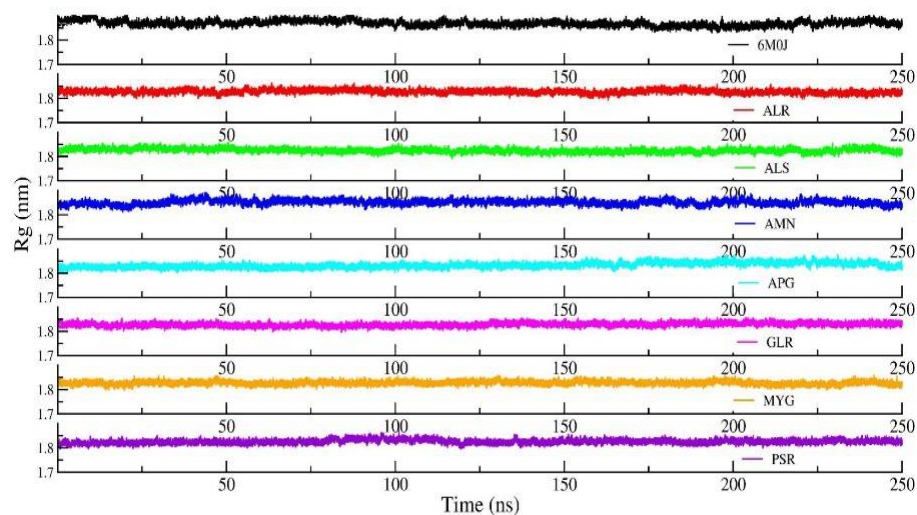
Figure 5. Time dependence of the root mean square deviation (RMSD) of the protein from the pro- duction run of all seven protein–ligand complexes and compared with protein in water simulation.